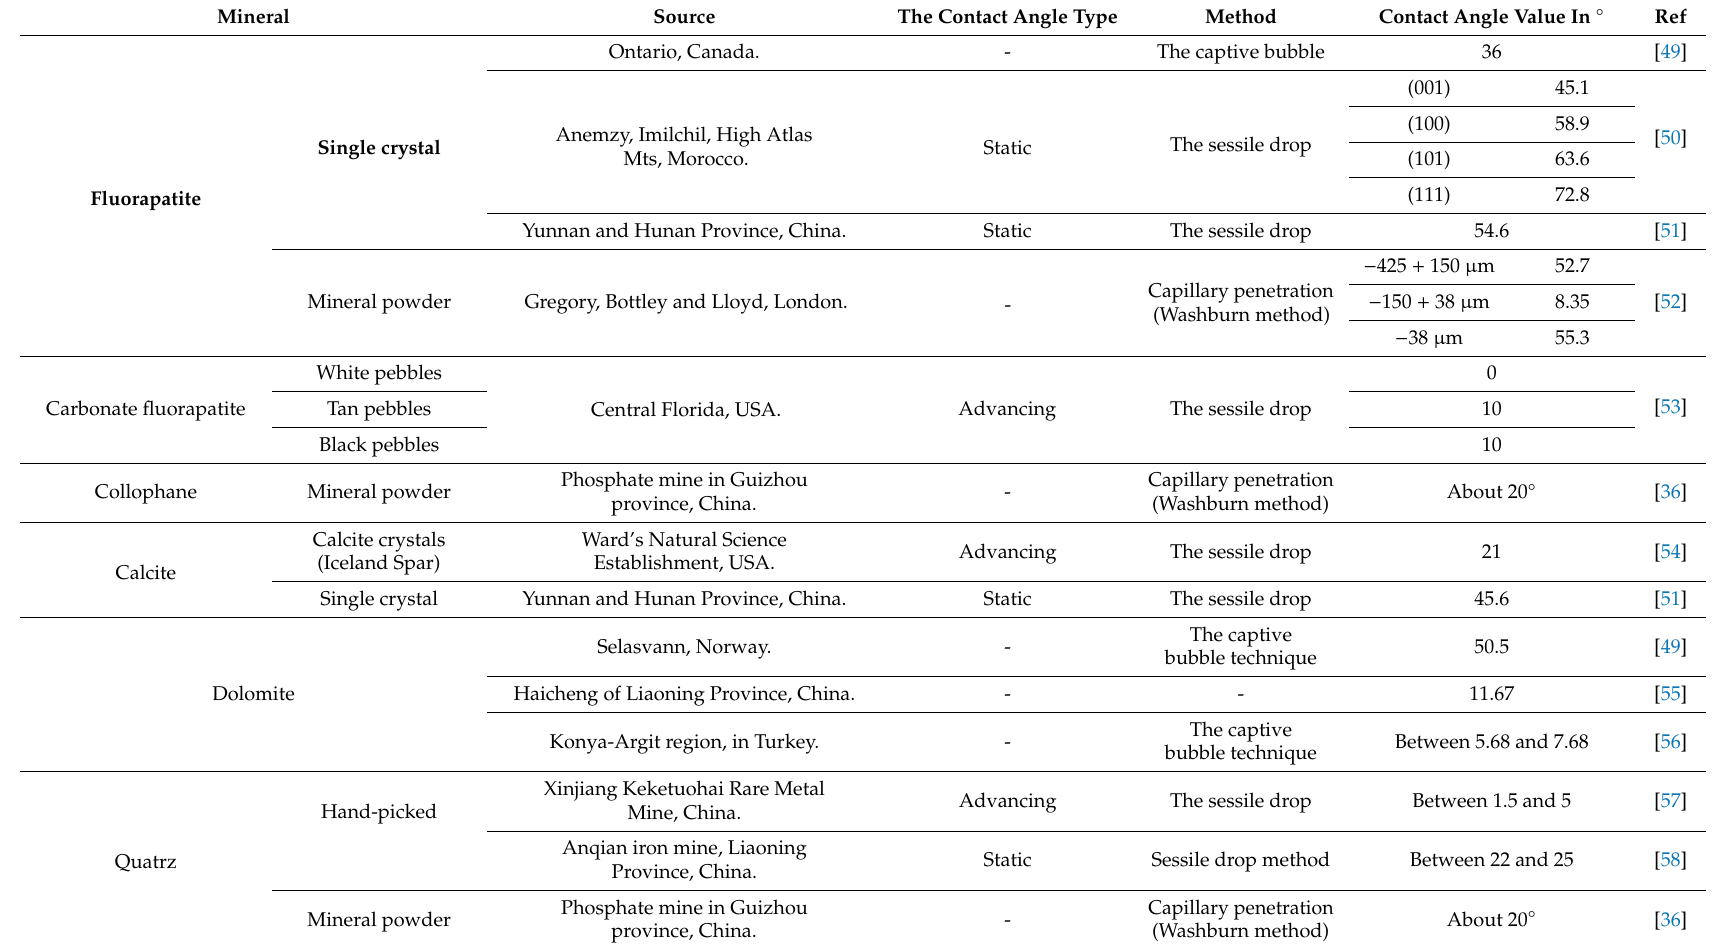
Table 8. Contact angle values of phosphate minerals, calcite, dolomite, quartz, and their measurement conditions.